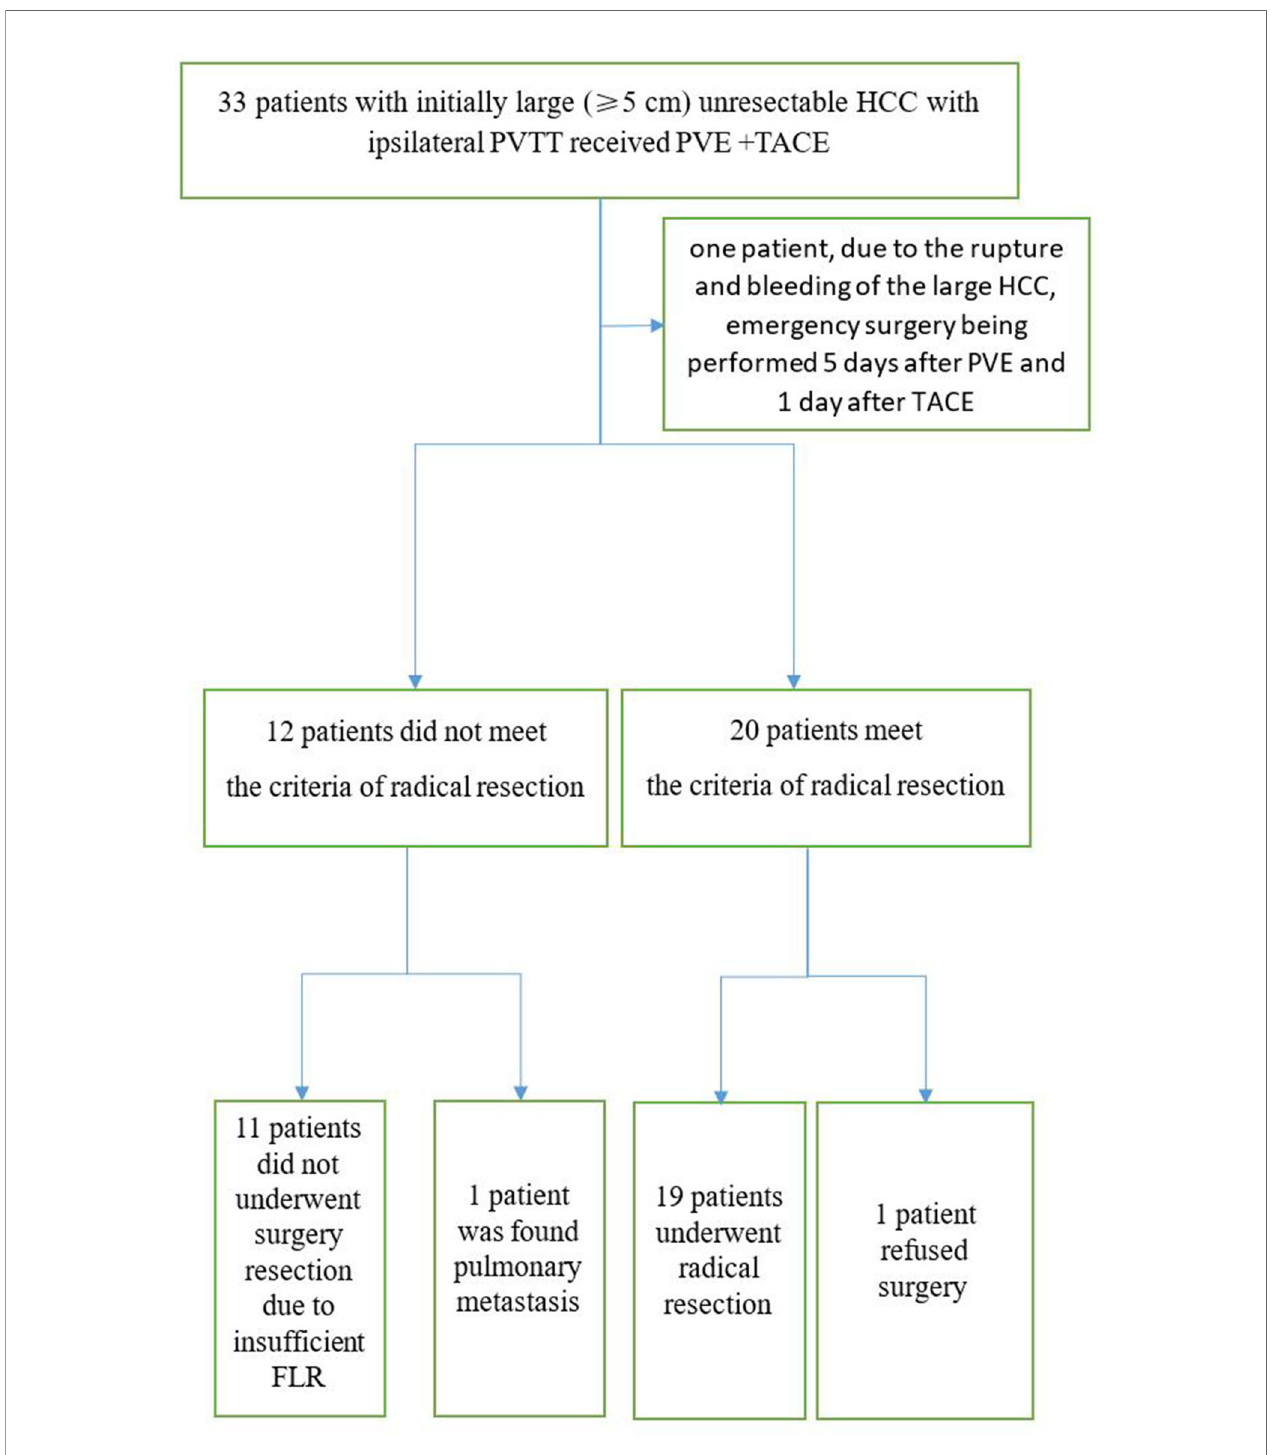
FIGURE 4 | Consolidated Standards of Reporting Trials diagram including all 33 patients who entered the study. PVE, Portal vein emboliaztion; PVTT, Portal vein tumor thrombus; TACE, Transarterial chemoembolization.